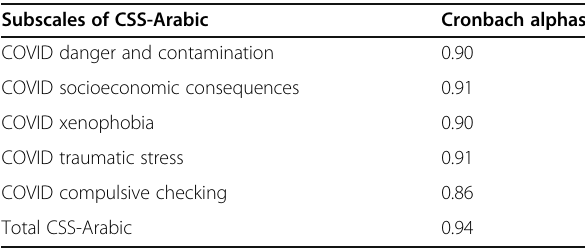
Table 5 Cronbach alphas of CSS-Arabic Subscales of